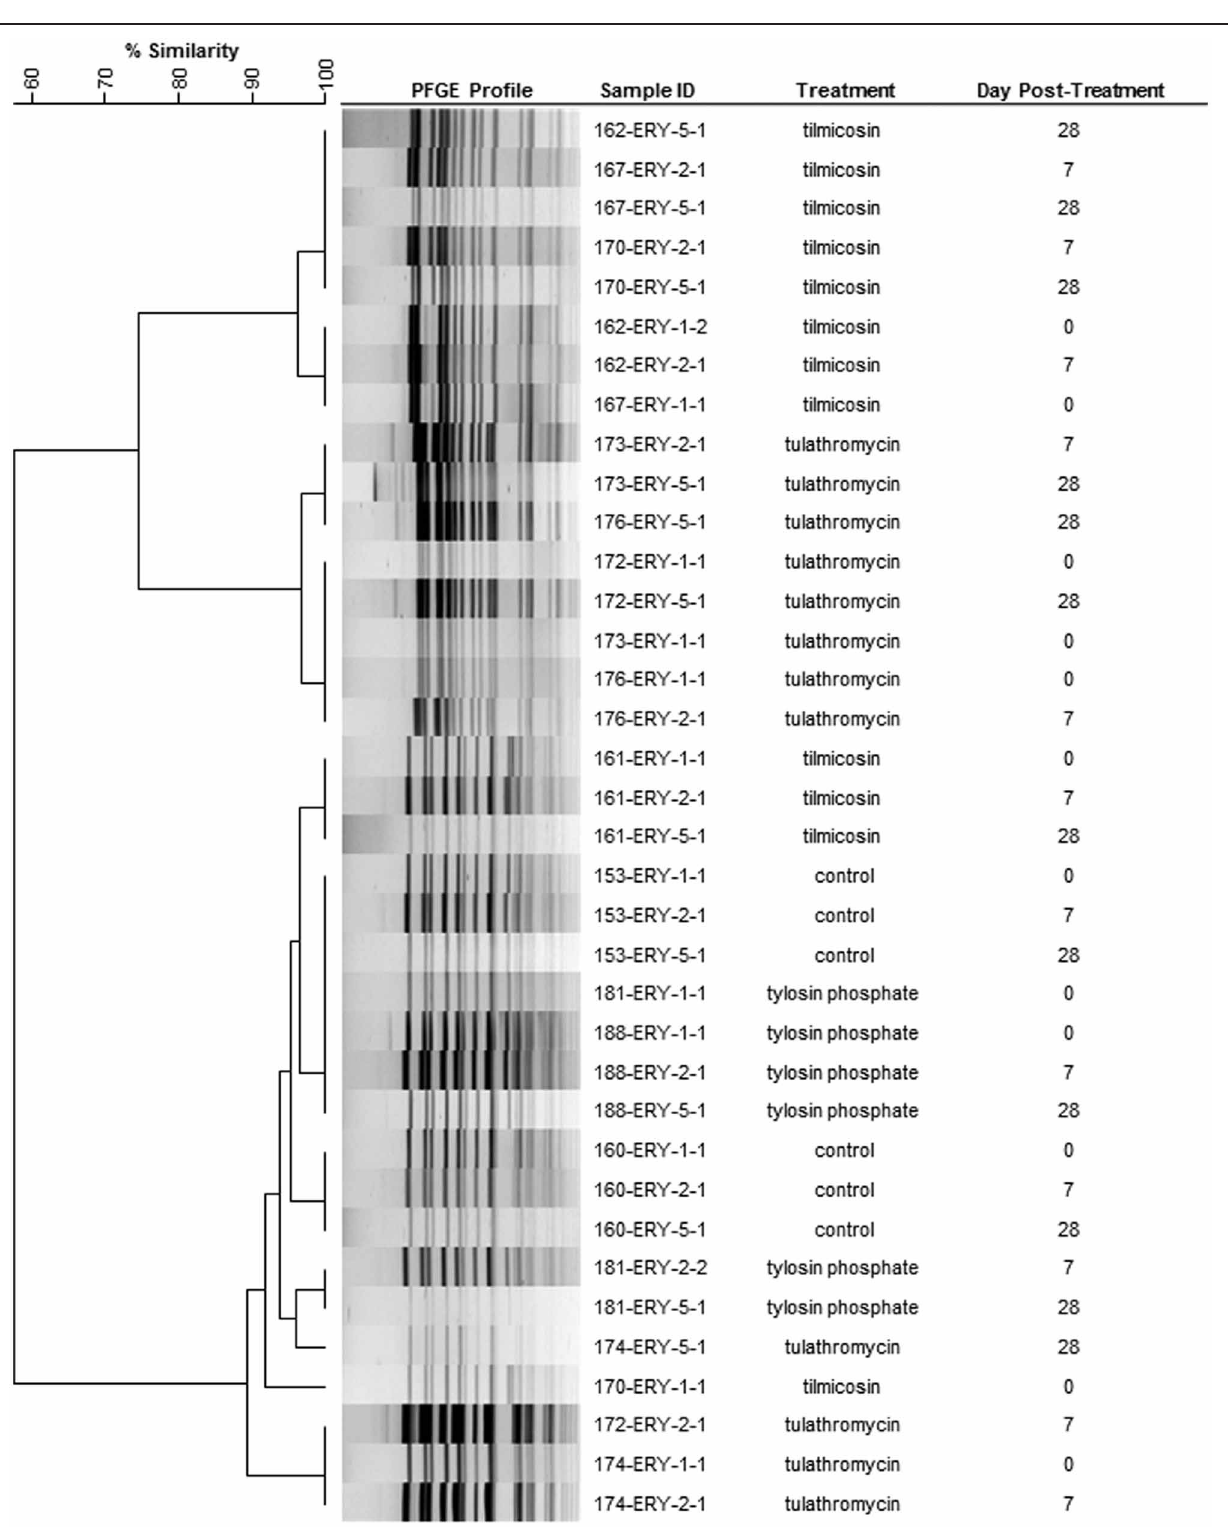
on 5th sampling event (day 28) from animal #153. (Control: animal IDs 151–160; tilmicosin: animal IDs 161–170; tulathromycin: animal IDs 171–180; tylosin: animal IDs